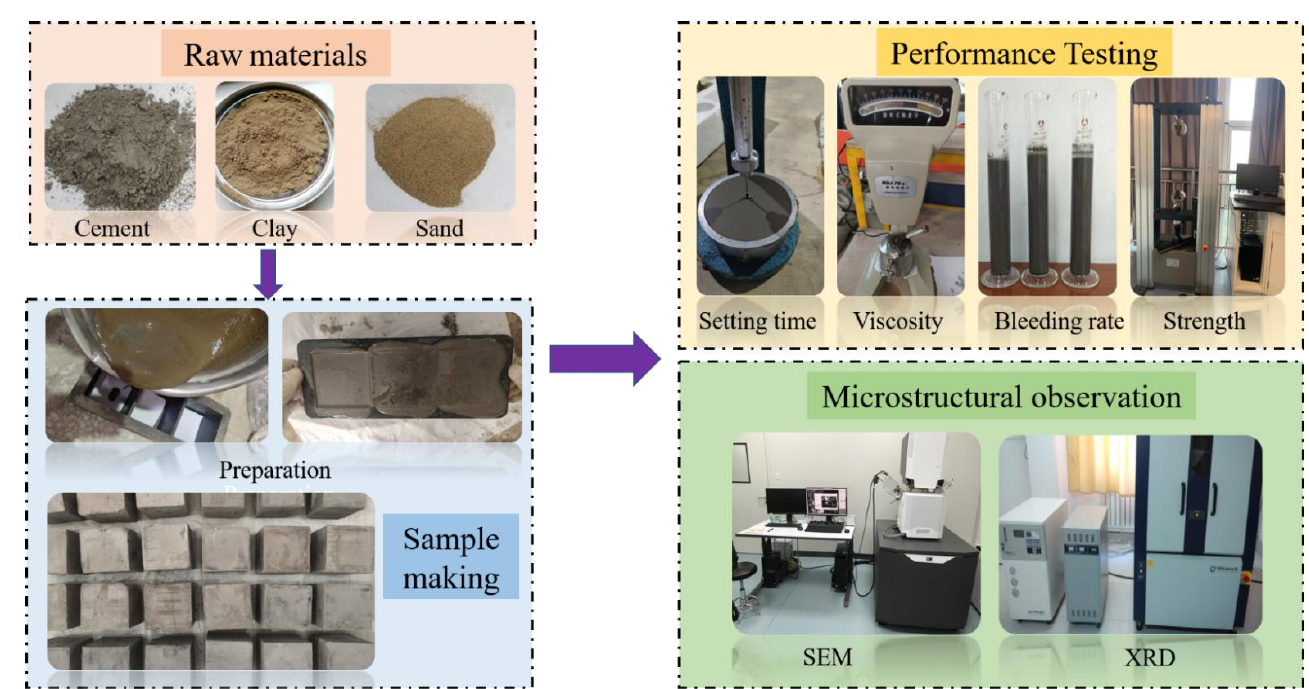
Figure 1. Experimental process.